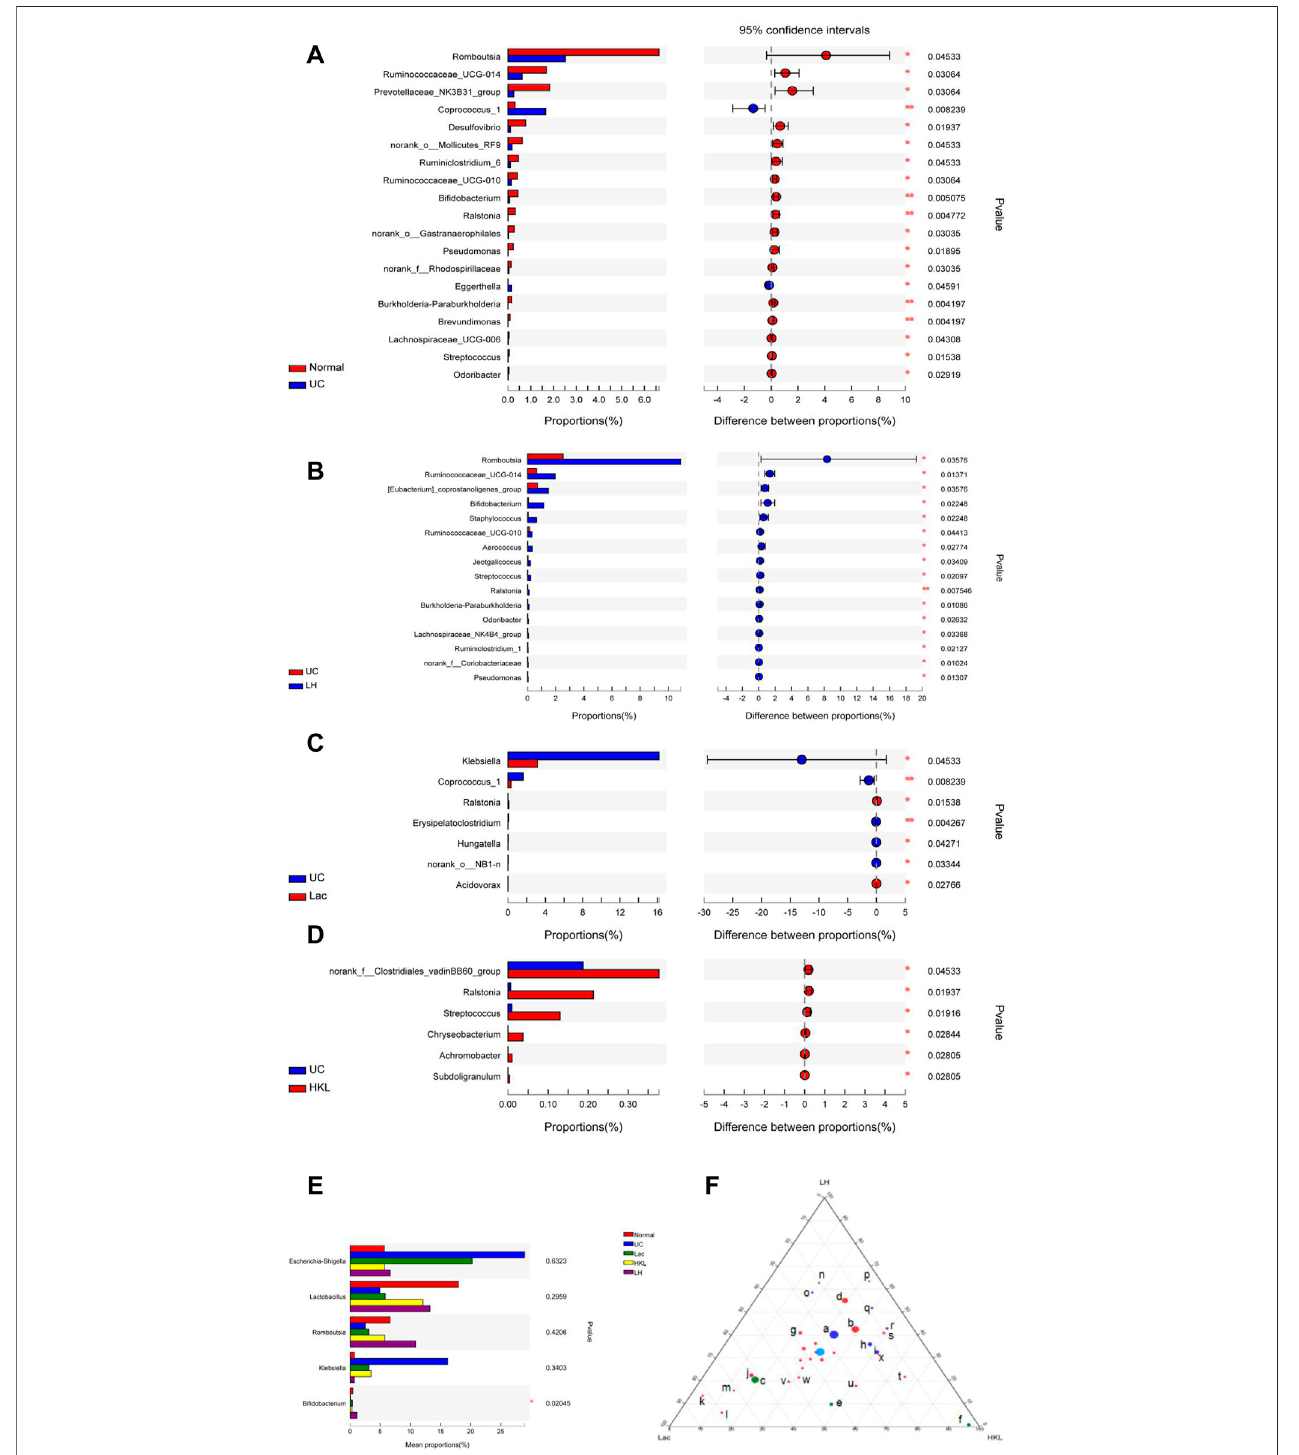
FIGURE 6 | Bacterial abundance at the genus level ( n = 5~6). Differences between normal and UC (A) ; UC and LH (B) ; UC and Lac (C) ; and UC and HKL (D) . (E) Comparison between groups of several bacteria with large change in abundance; (F) Ternary chart in Lac, HKL, and LH groups. (a. bacteroidales_s24-7_grou p; b. lactobacillus ; c.Escherichia-Shigella; d.romboutsia; e. klebsiella ; f. pasteurella ; g.Turicibacter h. bacteroides ; i.Prevotellaceae_ Ga6A1_group; j.Lachnospiraceae_NK4A136_group; k.Ruminococcus_2; l.Blautia; m.(Eubacterium)_xylanophilum; n.Bi fi dobacterium; o.Prevotellaceae; p. Helicobacter ; q.Alloprevotella; r.Prevotellaceae_NK3B31_group; s.Entero coccus; t.Coprococcus_1; u.Lachnoclostridium; v.Christensenellaceae_R-7_group; w.norank_f_Ruminococcaceae; x.Prevotellaceae_Ga6A1_group).